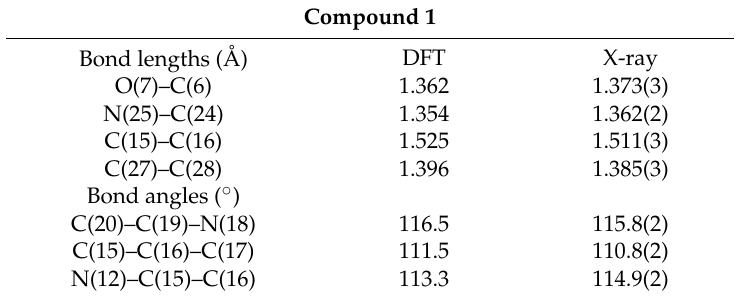
Figure 8. DFT-optimized conformations of compound 1 , 2 and 3 at the B3LYP/6-311G (d, p) level of theory. Table 6. Optimized geometrical parameters of theoretically calculated and solid-state conformers.